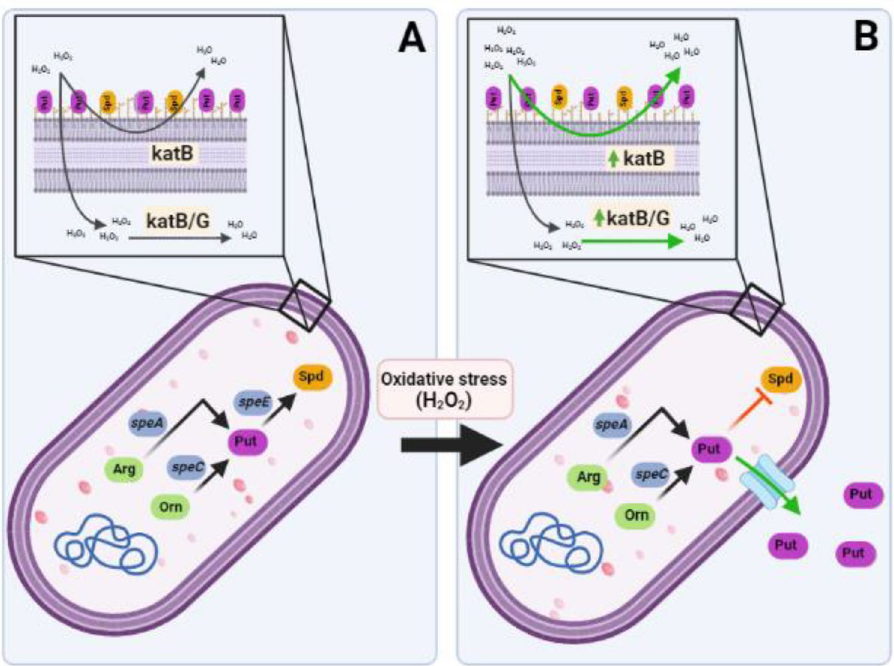
Figure 10. Diagram illustrating the alterations in polyamine metabolism and their relationships to the antioxidant response in Pst DC3000. ( A ) During optimal growth and development, bacteria usually deal with small amounts of extracellular concentration of H 2 O 2 , but also with autogenously generated intracellular amounts of this reactive species. Under these conditions, external H 2 O 2 (that may permeate through membranes) and internal H 2 O 2 are quickly metabolized by catalases. ( B ) During plant invasion, bacteria is recognized by the plant surveying system and a series of defense mechanisms are deployed imposing oxidative stress to the microbe. This implies the activation of plant enzymes that rise the extracellular concentrations of H 2 O 2 and the production of antimicrobial compounds that provoke an increment in the internal amounts of this compound. In response to these highly oxidative conditions, bacteria secretes Put to the extracellular medium. Interrupting the synthesis of Spd could also contribute to this response, as this leads to the induction of catalase activity. Besides, the outer membrane stabilizes as a result of this process, which may affect its permeability and reduce H 2 O 2